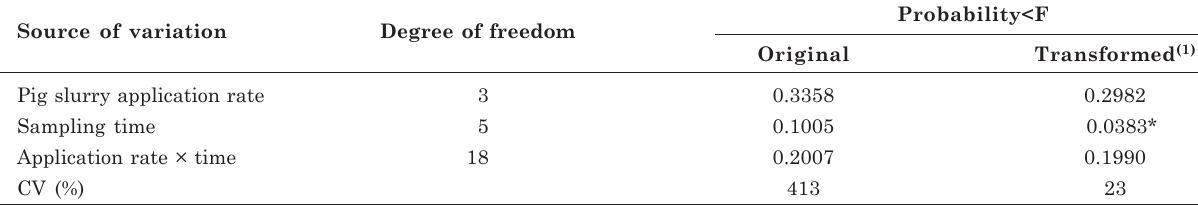
Table 4. Analysis of variance of the glyphosate mobility variable